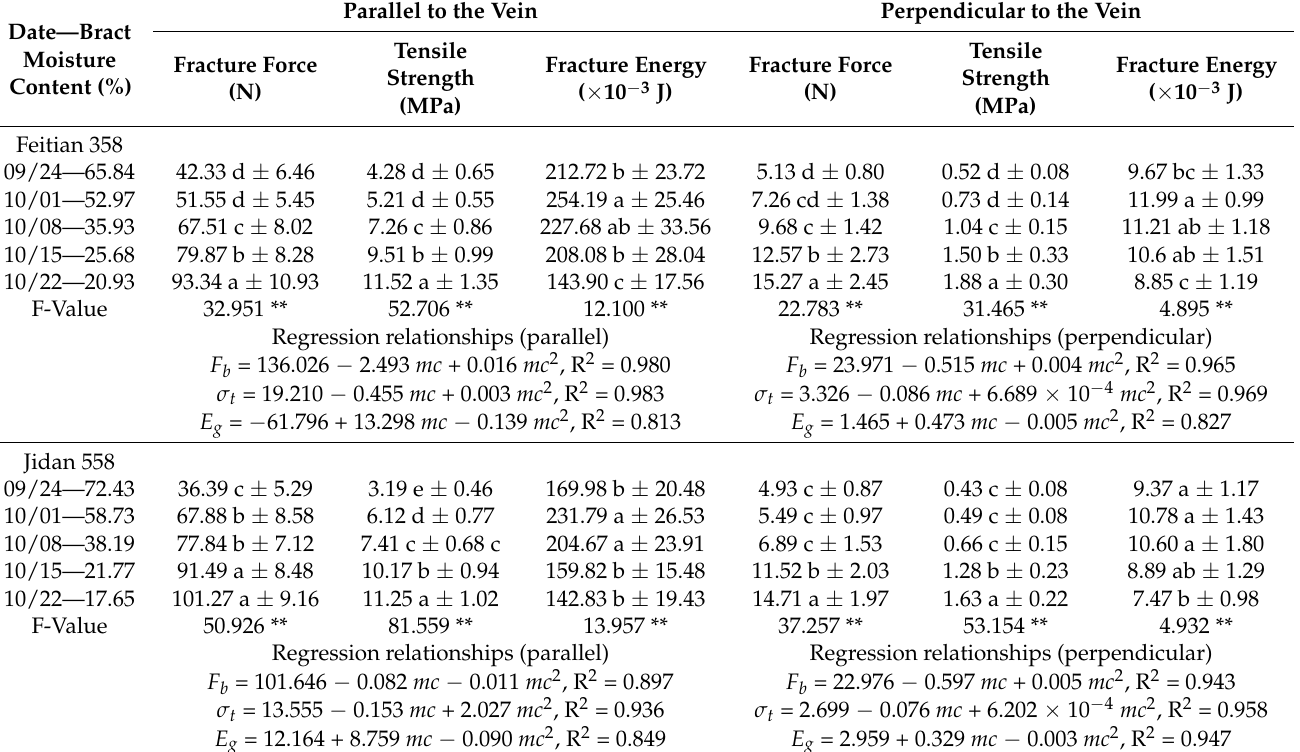
Table 3. Tensile properties of the third leaf blade from five harvest days (mean ± SD) and repeated measures analysis of